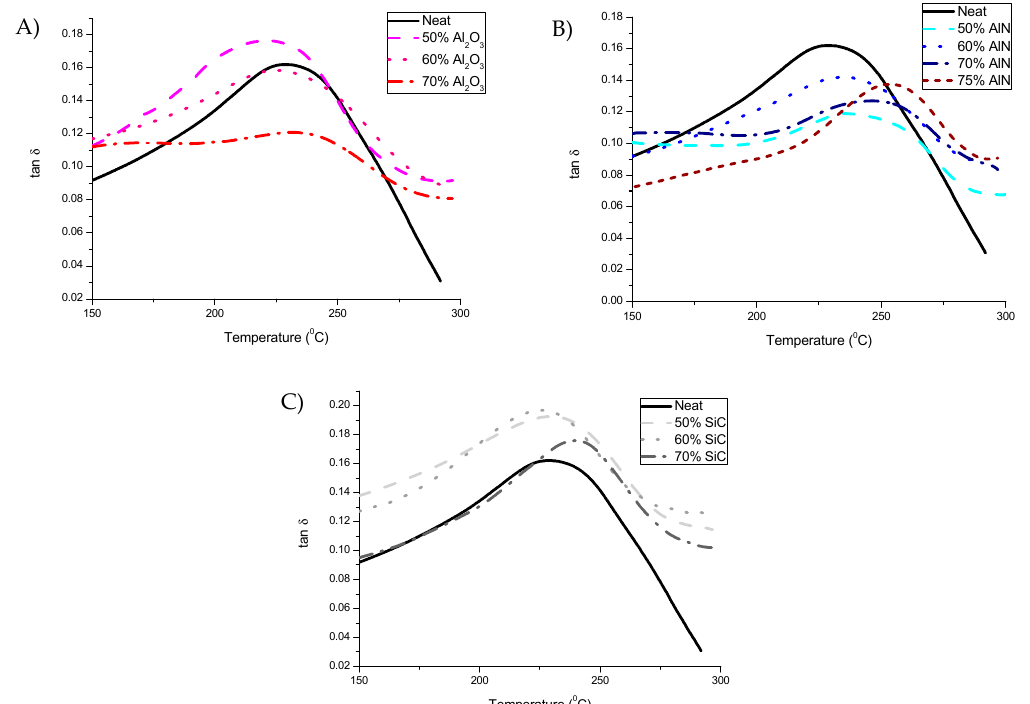
Figure 6. Curves of tan δ for the composites prepared determined by DMTA. ( A ) Al 2 O 3 ; ( B ) AlN; ( C ) SiC.